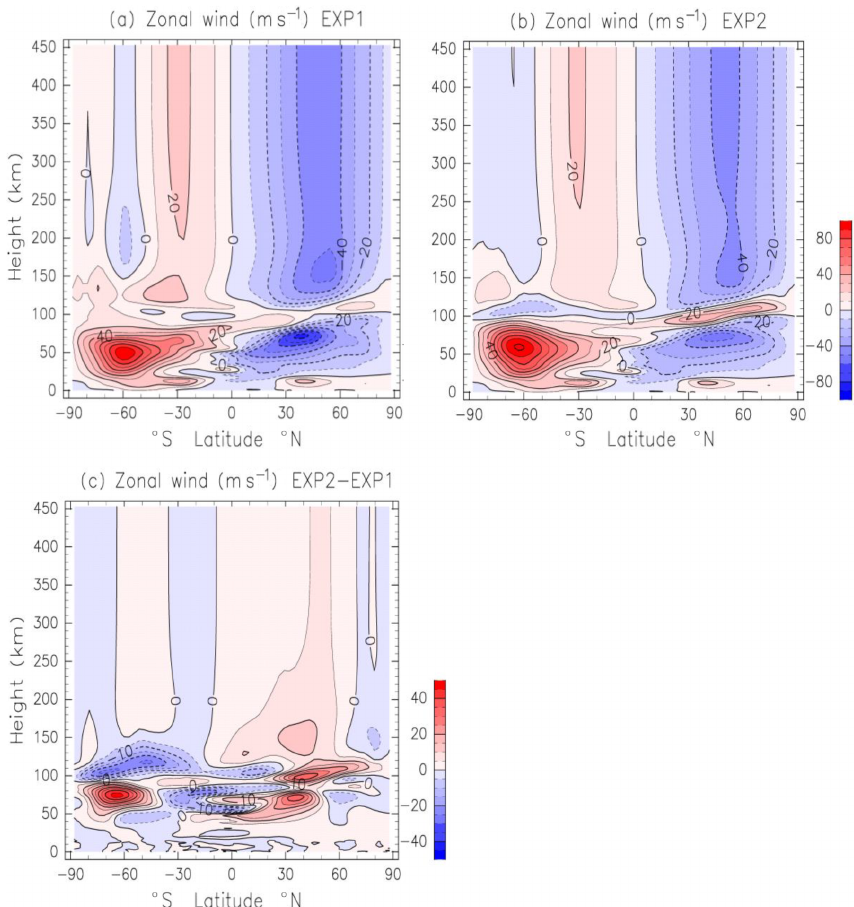
Figure 1. (a) Height–latitude section of zonal and diurnal-mean zonal wind obtained by EXP1 (the application of the Lindzen scheme below 100km height). Data are averaged from 1 to 30 June. Contour intervals of black lines are 10ms − 1 . Negative and positive values are eastward and westward winds, respectively. (b) As in (a) except for the application of the Yi˘git scheme in the whole atmosphere (EXP2). (c) Difference of the zonal wind between EXP1 and EXP2 (EXP2–EXP1). Contour intervals are 5ms − 1